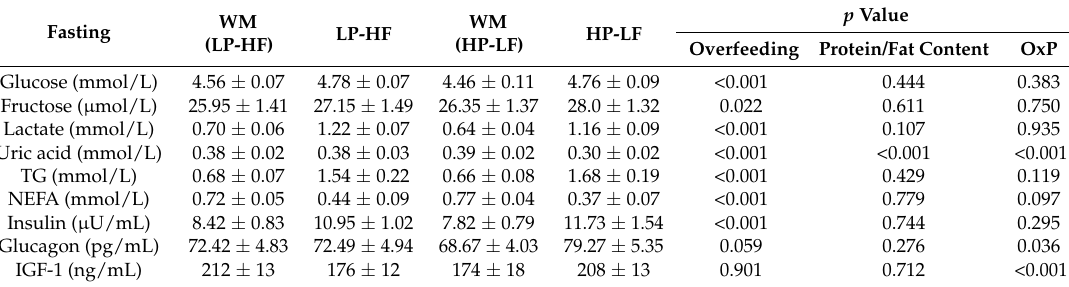
Table 2. Fasting plasma metabolites and hormones concentrations.